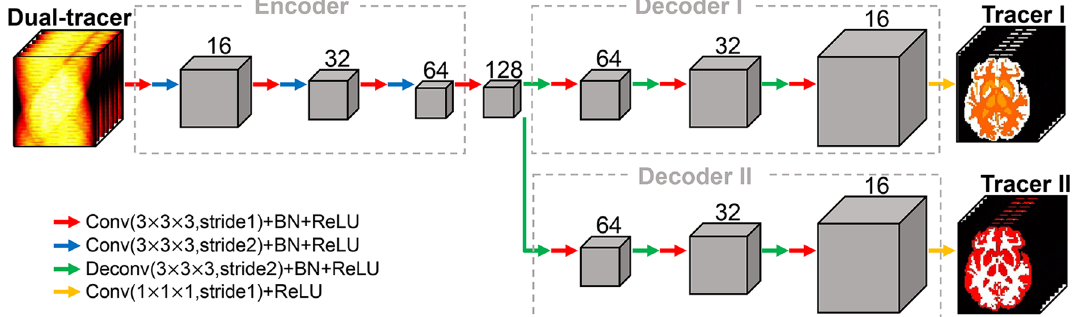
Fig. 1 The architecture of Multi-task CNN. The dual-tracer dynamic sinogram is inputted to the encoder, and two decoders output the dynamic activity images of two tracers. Conv layer. The kernel size and number of channels are noted in the